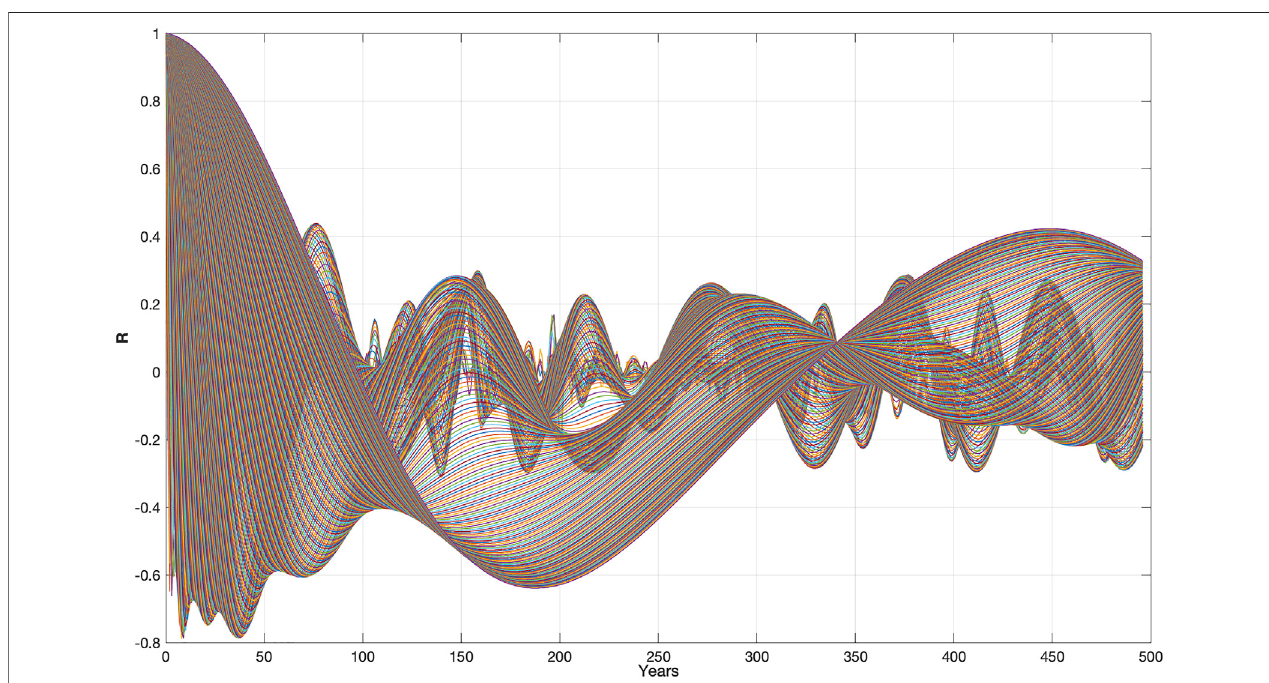
FIGURE 8 | Greenland ’ s temperature (GISP2) wavelet autocorrelation spectrum, WRgrt (Rgrt(s), m), for s = (1 ... 500) and m = (1...500)